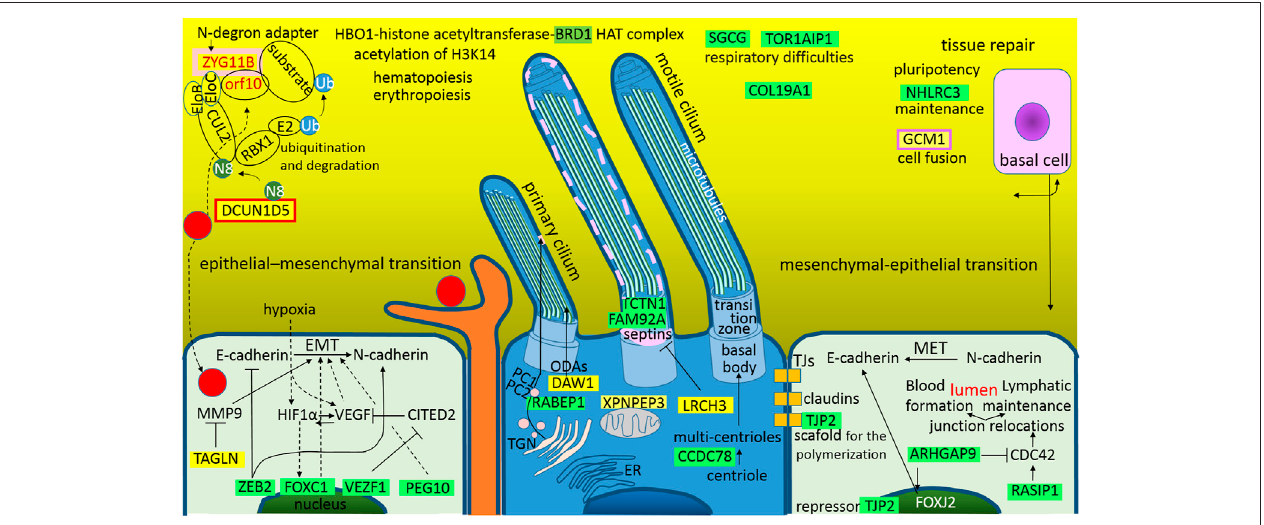
FIGURE 6 | The graphical illustration of “ Altered homeostasis in the pulmonary epithelial tissue during the SARS-CoV-2 infection. ” Green highlights show the alignments with the complement sequence (post-transcriptionally repressed); yellow highlights show the alignments with the reverse complement sequence (post- transcriptionally promoted). The functions of the identi fi ed genes/proteins by the methodology are summarized in Supplementary Table S1